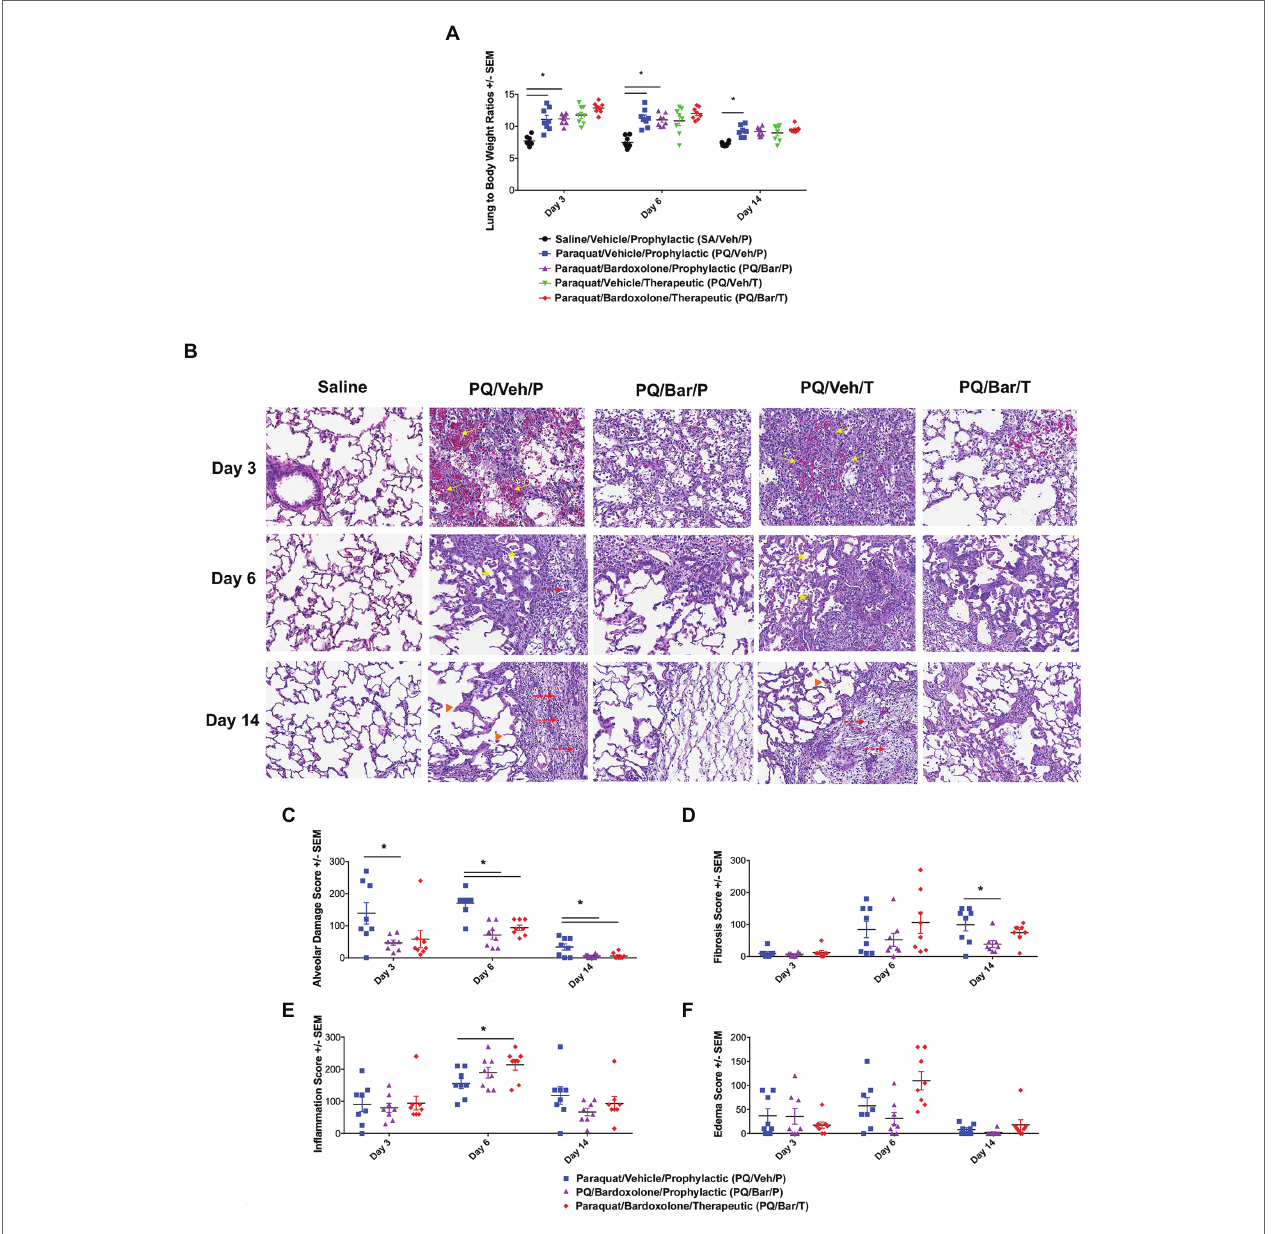
FIGURE 4 | Normalized, endpoint lung weights and histopathology confirmed lung injury and detected effects of bardoxolone treatment. (A) Lung weight to body weight ratios. Compared with SA/Veh/P rats, PQ/Veh/P rats showed higher normalized lung weights at all evaluated time points. * p ≤ 0.01 vs. SA/Veh/P. PQ/Bar/P also demonstrated higher normalized weights compared with SA/Veh/P rats on Days 3 and 6. * p ≤ 0.0001 vs. SA/Veh/P. (B) Lung histopathology. Lung histopathology confirmed that PQ/Veh/P and PQ/Veh/T rats exhibited alveolar hemorrhage, atelectasis, emphysema, and fibrosis during the course of study. At Day 3, the predominant histological findings were necrosis, loss of type 1 pneumocytes, hemorrhage, and fibrin accumulation within alveoli. Alveolar lumina were multi-focally collapsed and contained abundant hemorrhage, fibrin, and small amounts of necrotic debris (arrows), as well as edema, increased numbers of alveolar macrophages (immune cell infiltrates indicated by stars), and fewer neutrophils. By Day 14, the alveolar septa were expanded by proliferation of cuboidal type II pneumocytes (hyperplasia), fibrin, and varying amounts of fibrous connective tissue (fibrosis indicated by dashed arrows). Furthermore, the alveolar septa were discontinuous with clubbed ends forming large, confluent spaces (emphysema indicated by arrow heads). Perivascular and peribronchiolar connective tissues were expanded by hemorrhage, fibrin, edema, and scattered neutrophils. Rats treated with bardoxolone prophylactically and therapeutically (PQ/Bar/P and PQ/Bar/T, respectively) showed better resolution of alveolar injury. (C–F) Histopathology quantification. (C) Alveolar damage scores. Compared with PQ/Veh/P rats, PQ/Bar/P possessed higher alveolar damage scores at all evaluated time points, while PQ/Bar/T possessed higher scores on Days 6 and 14. (D) Fibrosis scores. Compared with PQ/Veh/P rats, PQ/Bar/P, but not PQ/Bar/T, rats possessed lower fibrosis scores on Day 14. (E) Inflammation scores. Compared with PQ/Veh/P rats, PQ/Bar/T, but not PQ/Bar/P, rats possessed higher inflammation scores on Day 6. (F) Edema scores. All study groups possessed similar edema scores at all evaluated time points. * p ≤ 0.05 vs. PQ/Veh/P. Error bars are +/ − SEM. n = 6–8 rats per group per time